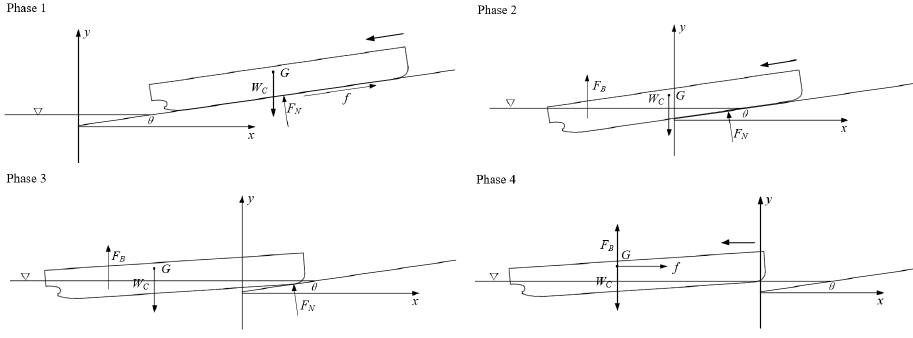
Figure 1. Four (4) stages of longitudinal ship launching.